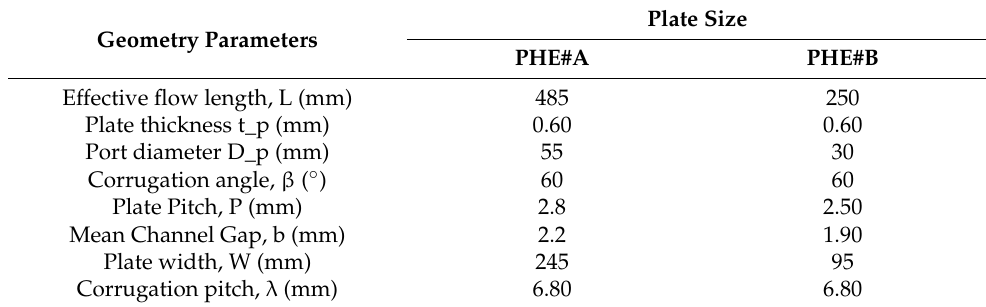
Figure 2. Schematic view of the chevron plate heat exchanger with the basic dimensions on the left side and a photograph of the two sizes on the right side. Table 1. Geometrical characteristics of the